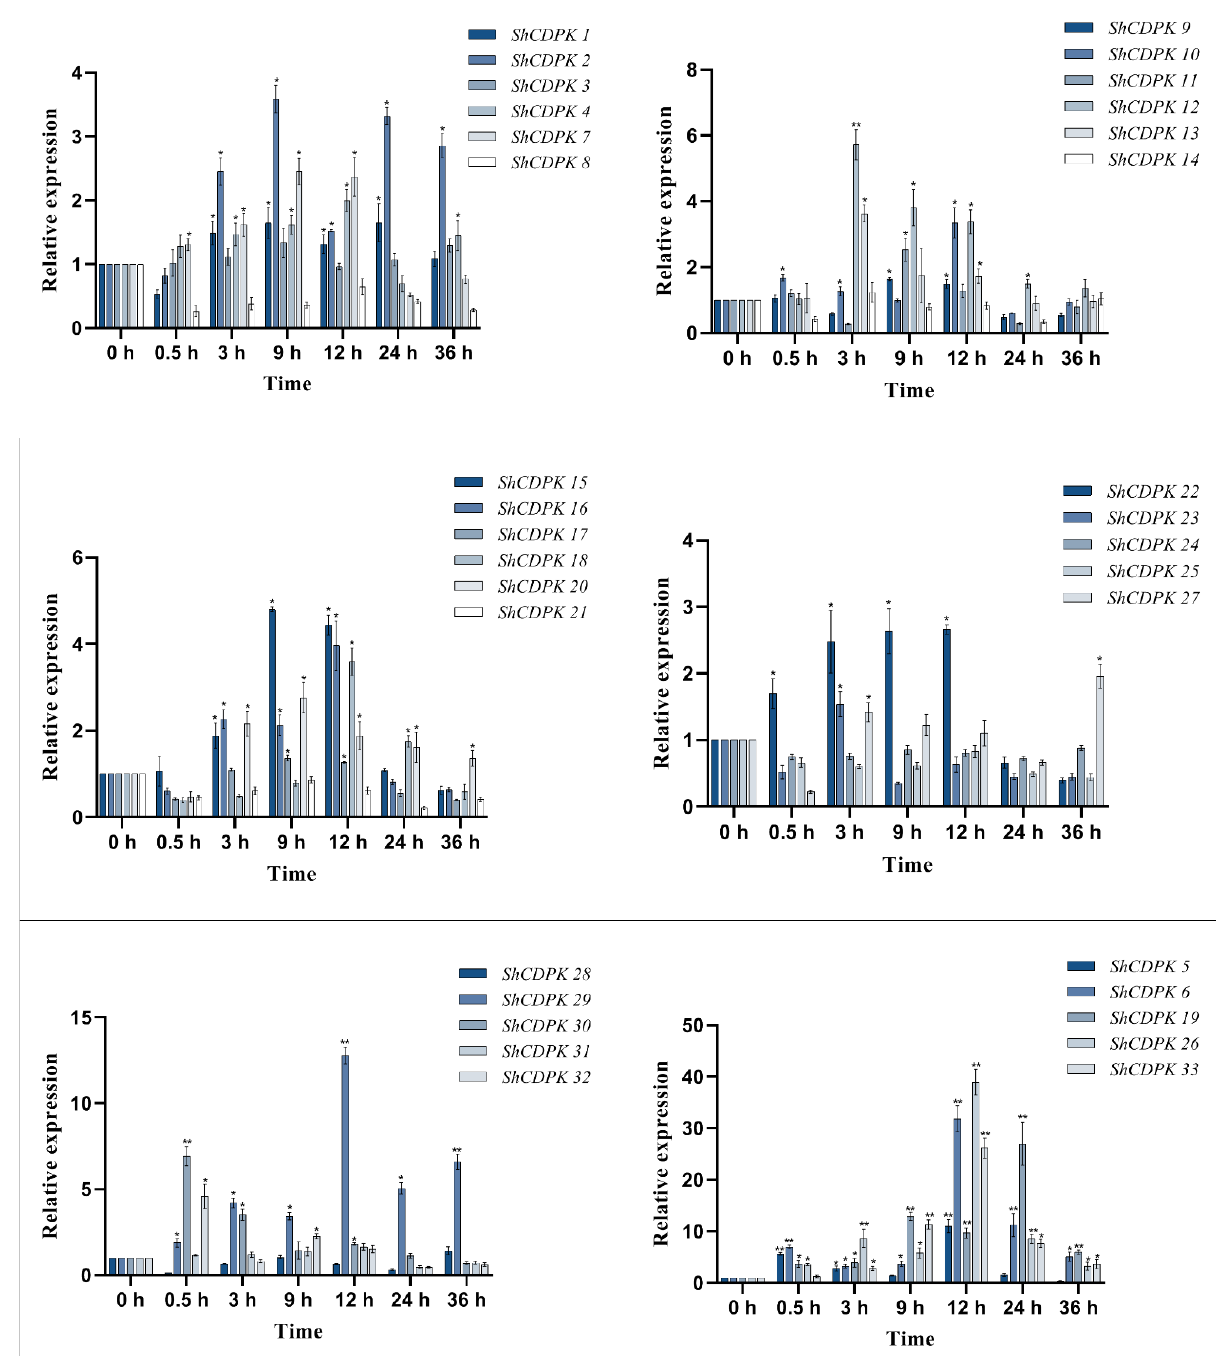
Figure 4. Expression analysis of CDPKs gene in Solanum habrochaites with real-time PCR under cold stress. Quantitative PCR data are represented as mean ± SEM. ** p < 0.01, * p < 0.05. All date represent mean values for three independent biological replicates.